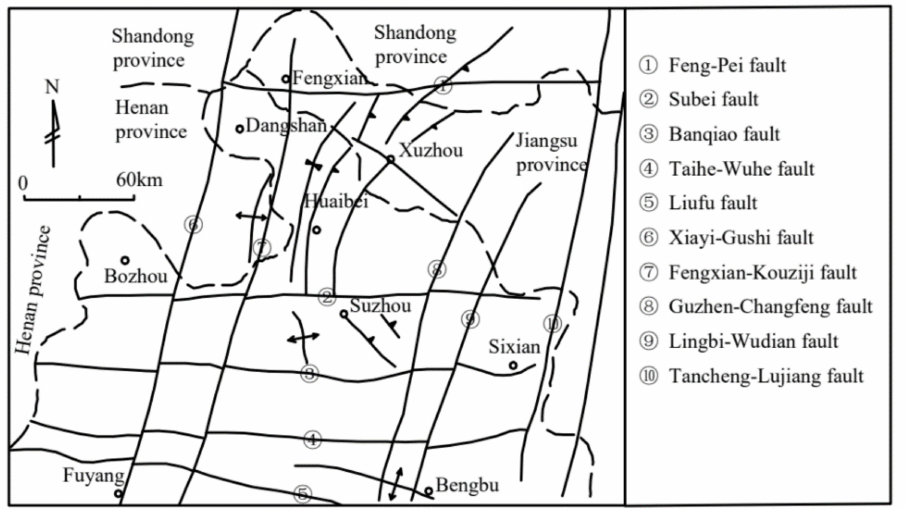
Figure 1. Tectonic outline map of the Huaibei coalfield. Modified from